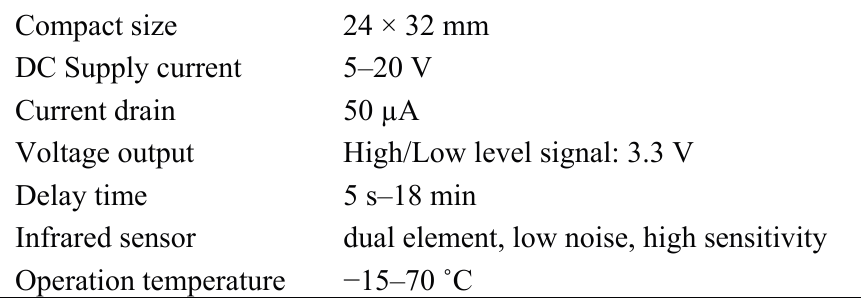
Table 1. Feature and Electrical Specification of NT0071.